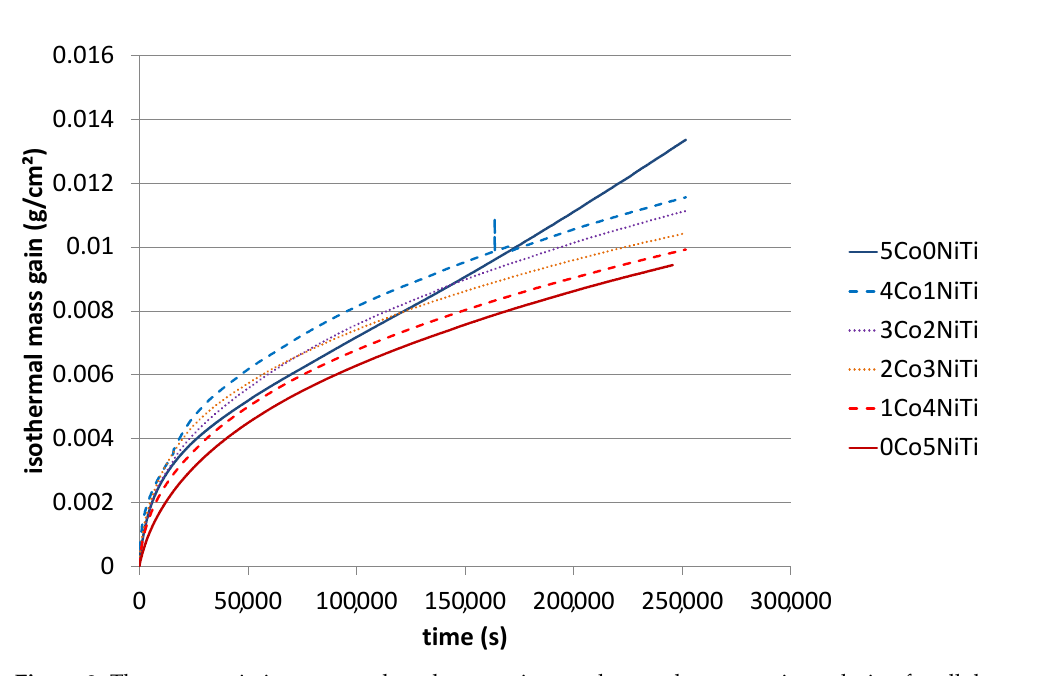
Table 3. Values of the kinetic constants determined for the isothermal oxidation using the classical method (5Co0NiTi) or the complete method taking chromia volatilization into account (the five other alloys).